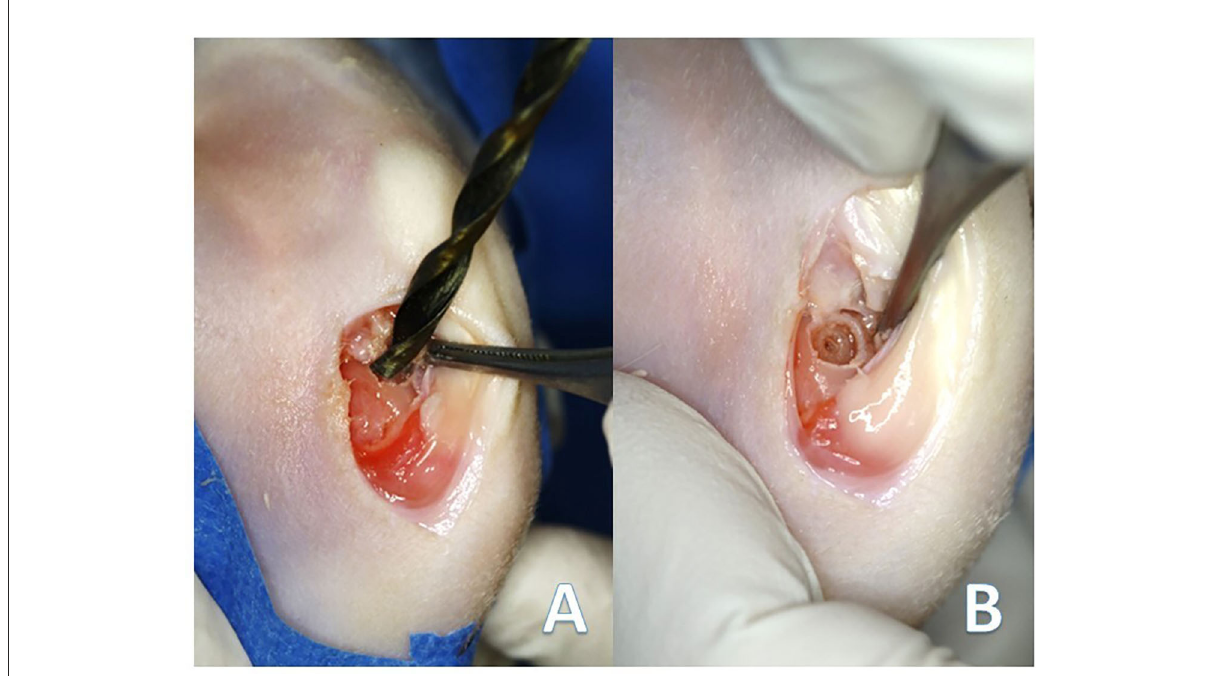
FIGURE1 (A) Creation of the chondral defect in the medial femoral condyle of the rabbits with the drill bit. (B) Final defect 4mm in diameter and 5mm in depth.